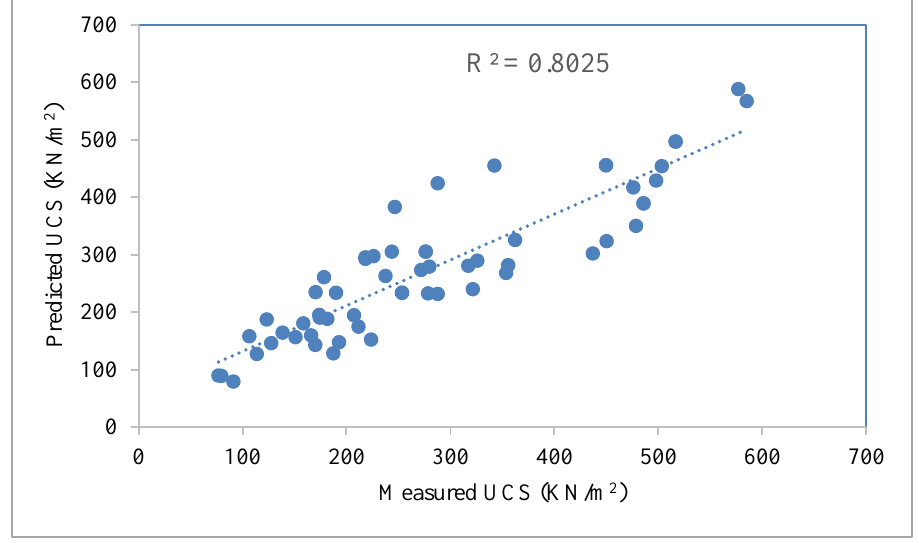
Fig. 3. Measured and predicted UCS from the transformed regression model.